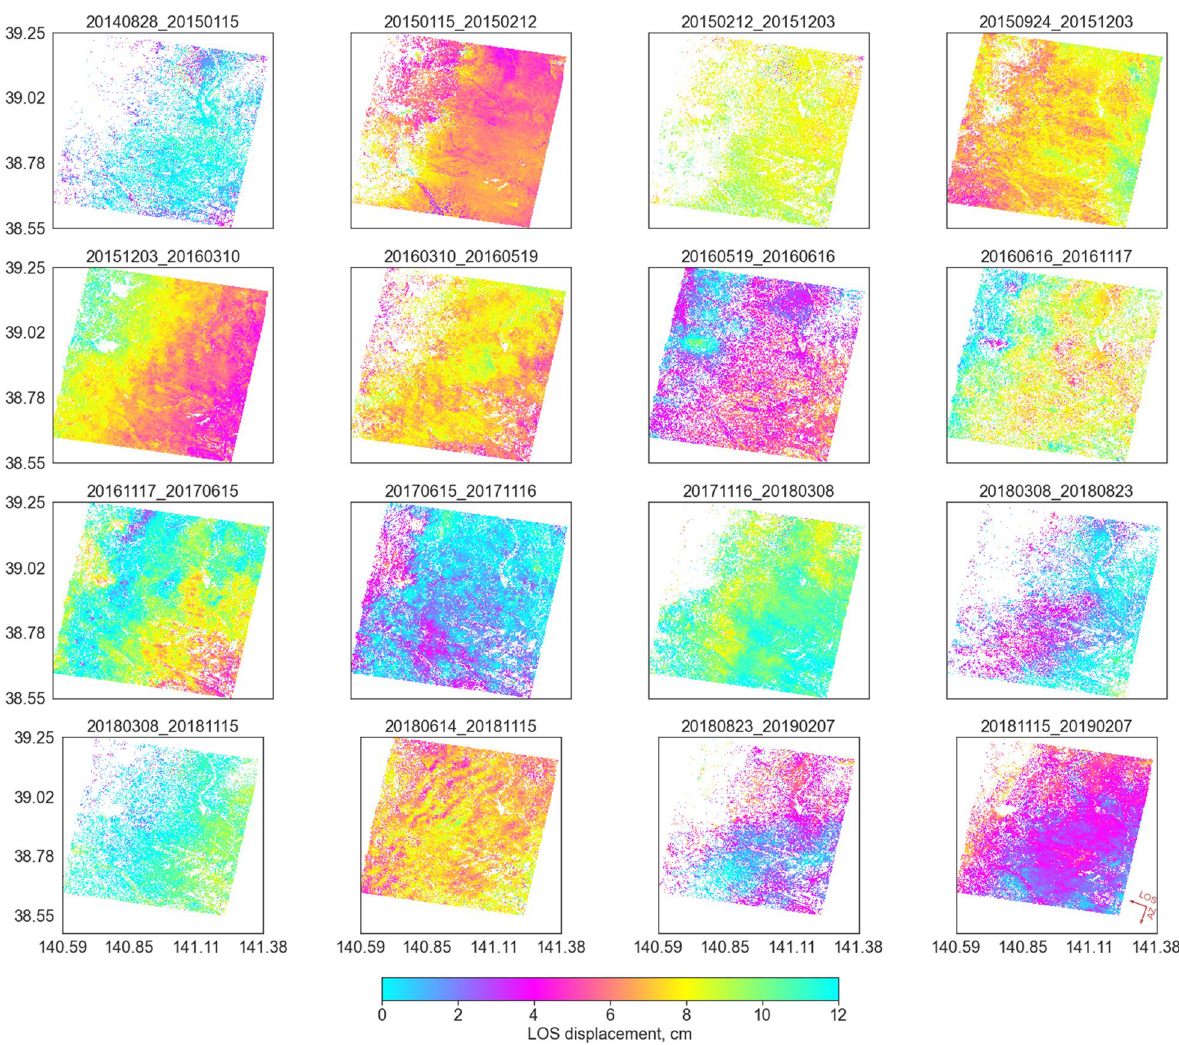
Fig. 3 Examples of ionosphere-corrected descending interferograms obtained using the split-spectrum method for the Tohoku region. The acquisition dates are shown above each interferogram. The incoherent pixels with a coherence threshold < 0.12 were masked in this